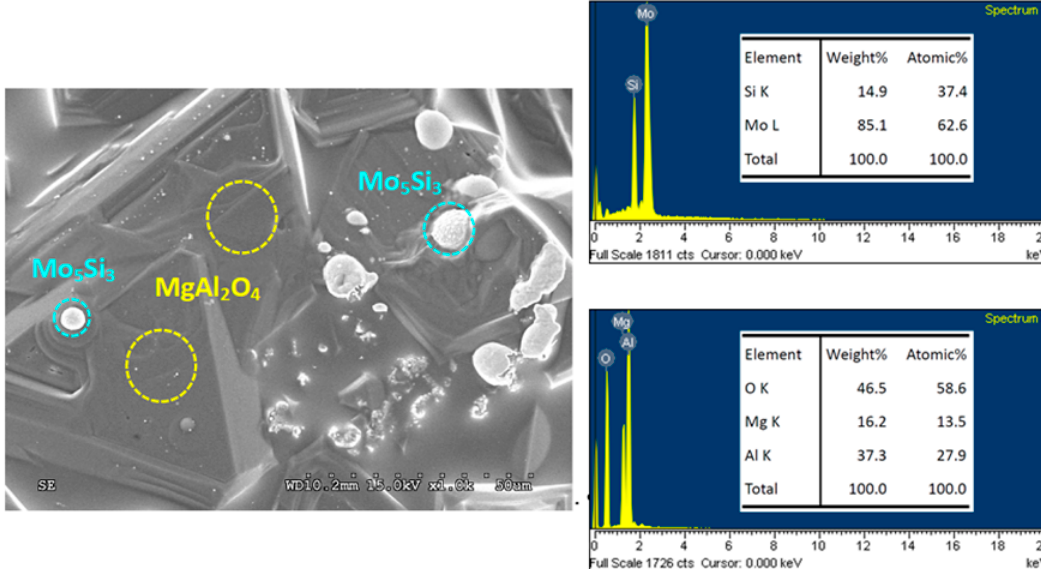
Figure 6. Scanning electron microscopy (SEM) micrograph and energy dispersive spectroscopy (EDS) spectra of Mo 5 Si 3 /MgAl 2 O 4 composite obtained from Reaction (1) with x = 1.5.